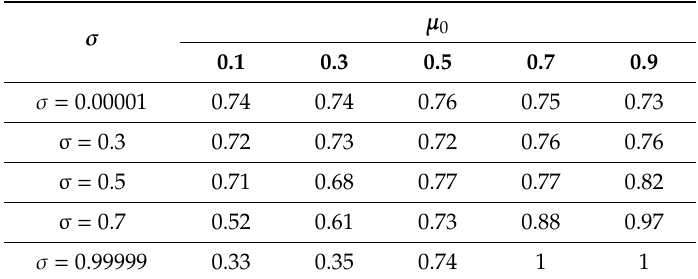
Table 2. The values of R t based on di ff erent σ and µ 0